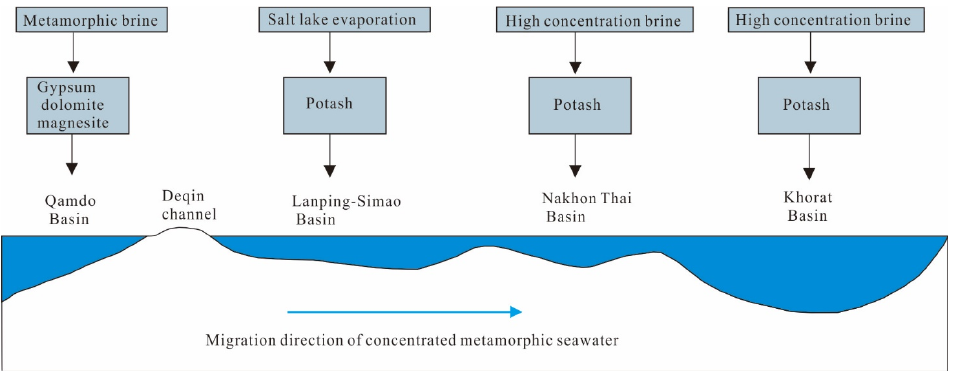
Figure 13. Metallogenic model of Cretaceous evaporation deposit in Lanping-Simao-Korat basin (modified after Li, 2015 [18]).